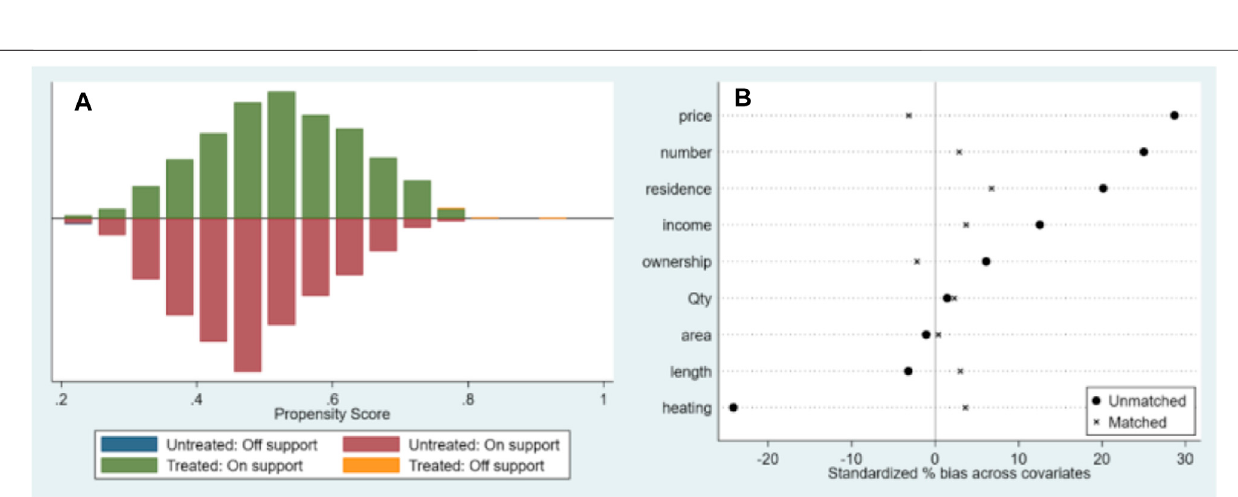
Figure 3A , a signi fi cant portion of observations of electricity bills and smart meters are among the common ranges.